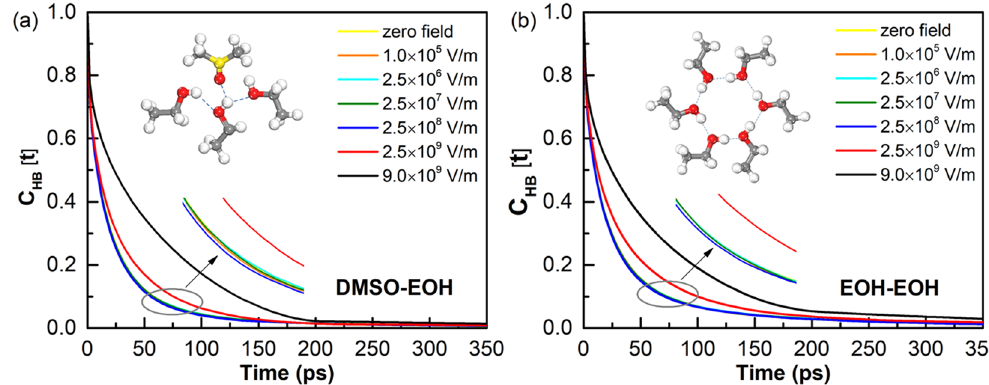
Figure 5. Hydrogen bonding autocorrelation functions in DMSO-ethanol mixtures versus simulation time with different field intensities: ( a ) DMSO-ethanol; ( b ) ethanol-ethanol. Where the curves represented the field intensity below 2 5 10 7 . × V/m are completely coincides with the curve represented the E 2 5 10